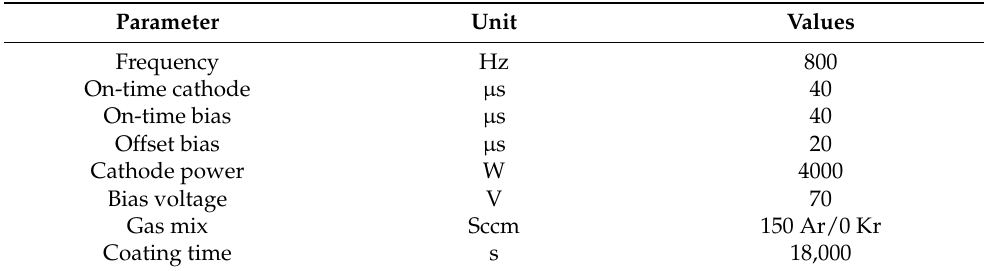
Table 2. Overview of parameters used for the coating of tungsten carbide with cobalt (WC-Co) specimens. Parameter